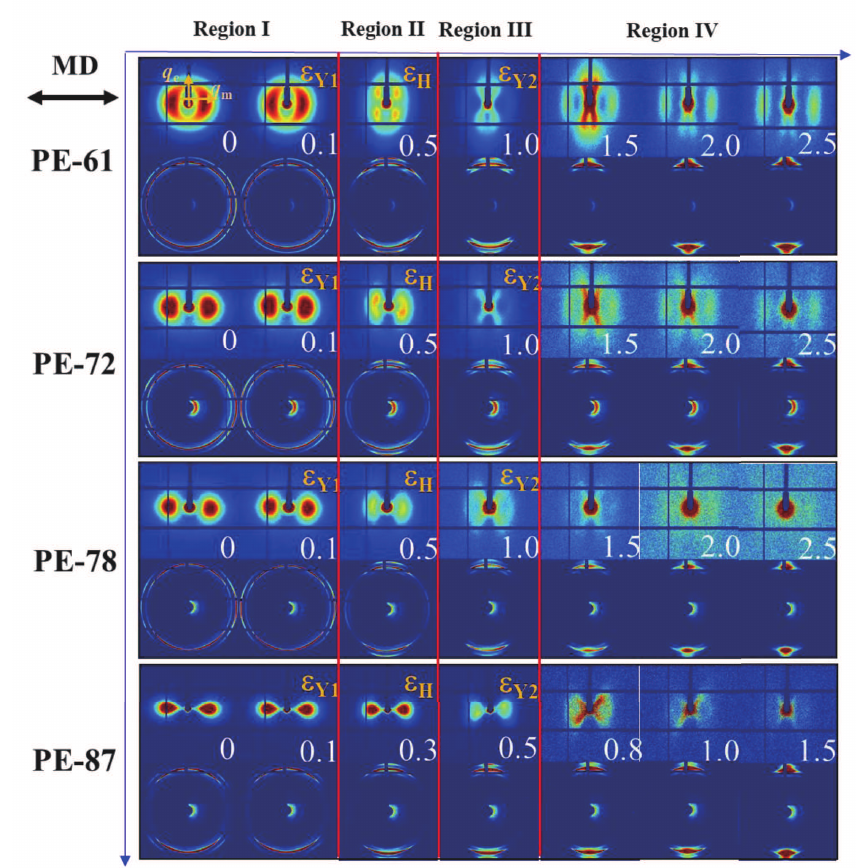
Figure 3. Representative 2D SAXS and WAXS patterns for mLLDPE precursor films with different orientations during the uniaxial tensile deformation. The corresponding strain is shown in the right corner of the 2D SAXS pattern. The tensile direction is